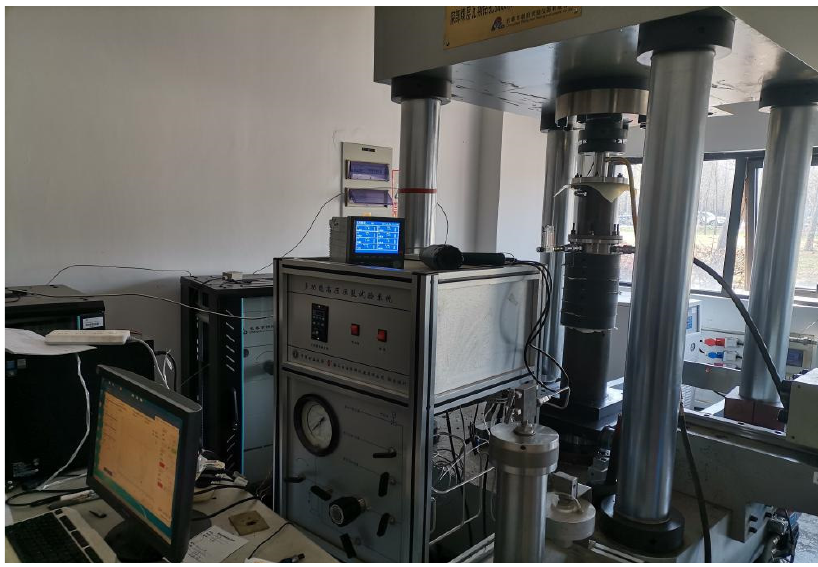
Figure 2. Coal rock mechanics-seepage test system (TAWD-2000). Table 1. The specifications of TAWD-2000 device.